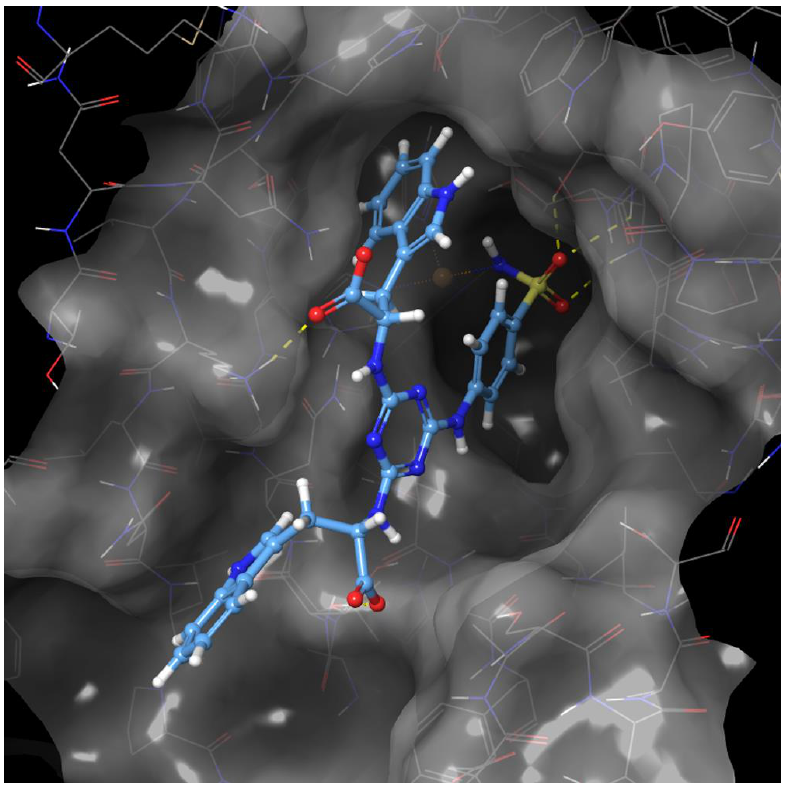
Figure 5. Molecular surface of the binding site of hCA XII with docked compound 6 (Trp derivative).